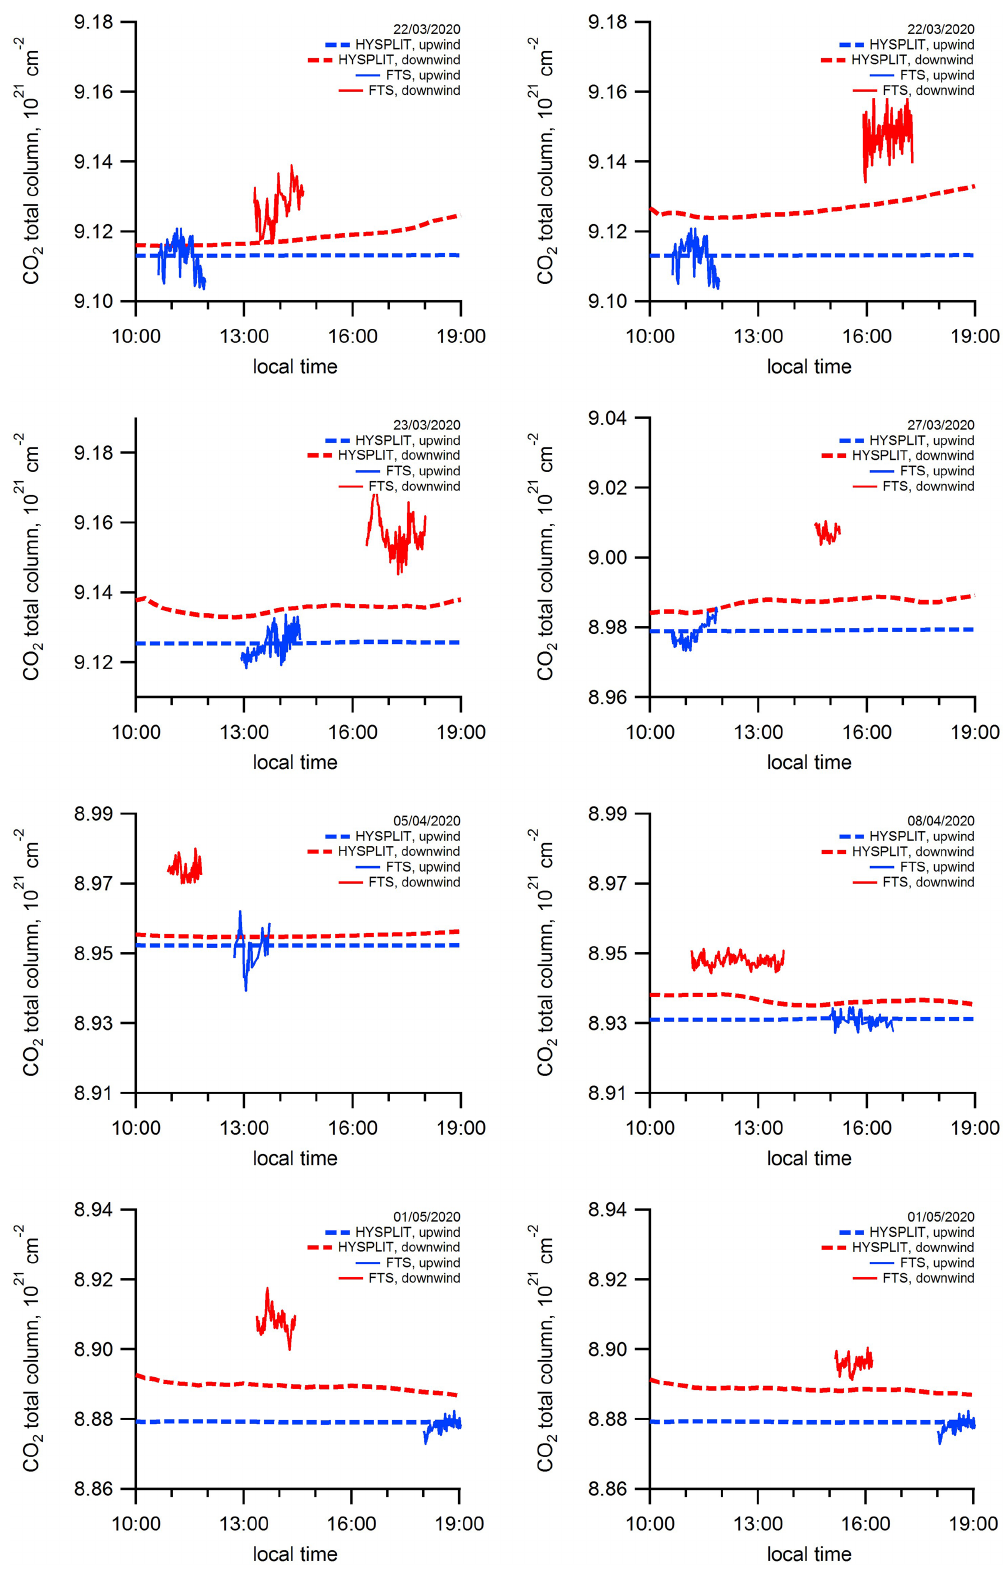
Figure B2. Time series of measured (FTS) and simulated (HYSPLIT; without scaling of the ODIAC emissions data) CO 2 total column at the upwind (blue lines) and downwind (red lines) locations for selected campaign days in